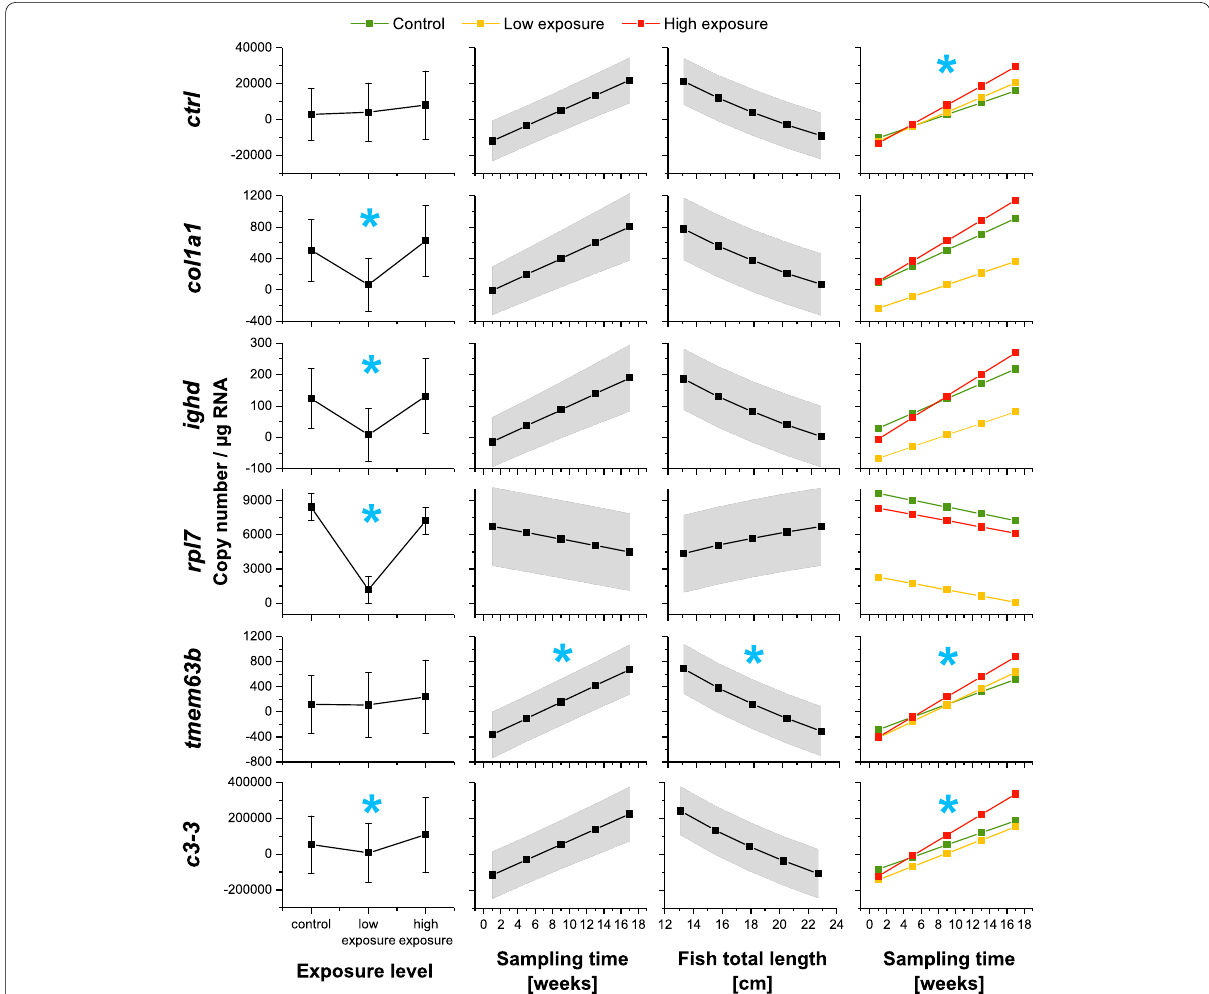
Fig. 8 Grand marginal means of selected linear models, examining statistically significant model effects on transcript concentrations of selected features derived from the proteom analysis and established stress genes from the literature. Grey bands indicate standard deviation. Asterisks indicate statistically significant differences between model effects. The last column illustrates the interaction of sampling time and exposure level in the utilized models (for more details, please refer to Table S5). Information about the general function of the analyzed proteins can be found